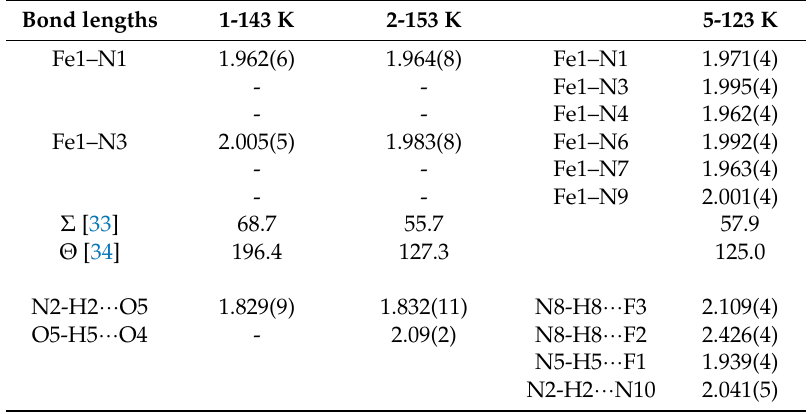
Table 4. Selected bond lengths, octahedral distortion parameters and hydrogen bonding distances (Å,°) for 1 , 2 and 5 .